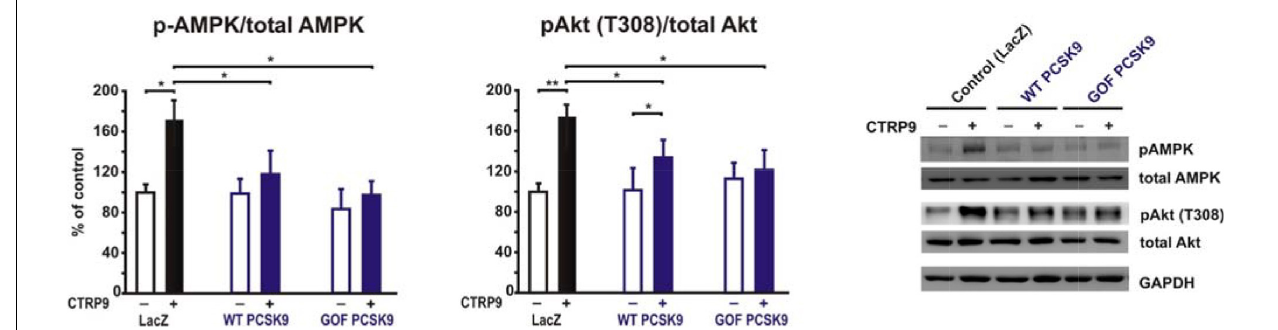
FIGURE 5 | Impact of PCSK9 on CTPR9-induced signal transduction. Adult rat cardiomyocytes were incubated in the presence of LacZ-containing supernatant (control), murine wild-type PCSK9 or GOF PCSK9 (each 0.5 µ g/ml) in serum-free medium for 24 h and subsequently treated with CTRP9 (4 µ g/ml) for 20 min. Activation of AMPK and Akt was analyzed by Western Blotting. Representative Western blots and densitometry of protein data are shown. Total AMPK and Akt as well as GAPDH served as a loading control. All data are mean ± SEM, 4 independent experiments, n = 8–12 per group, * p < 0.05; ** p <